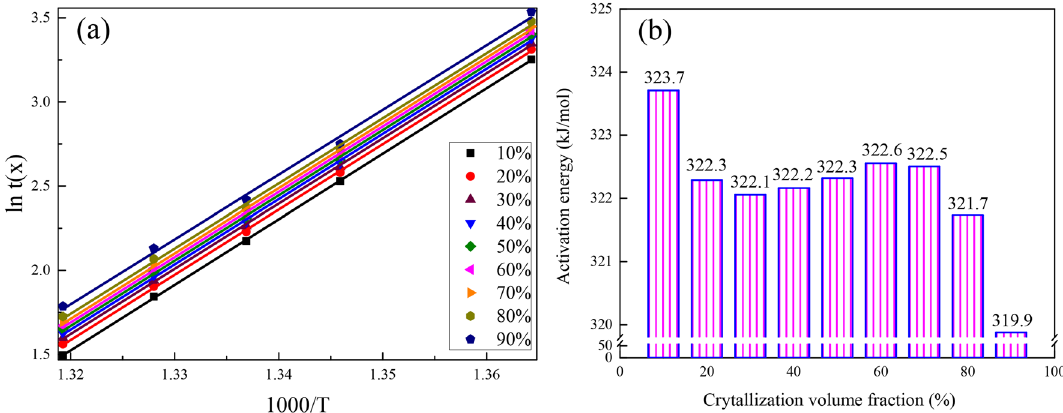
Figure 5. ( a ) Plots of ln t ( x ) versus 1000 /T and ( b ) activation energy E a versus crystallization volume calculated by Arrhenius equation 12,33 : t ( x ) = t 0 exp ( E a /RT ). Where t ( x ) is the time corresponding to crystallization volume fraction x , t 0 is a constant, E a is the crystallization activation energy, R is the molar gas constant, and T is the corresponding isothermal crystallization temperature. Figure 5a is obtained by plotting ln t ( x ) versus 1000/T and linear fitting the data under each crystallization volume fraction. The slope obtained by linear fitting can be calculated by the Arrhenius equation to acquire the relationship curve between the crystallization activation energy and the crystallization volume fraction x 8 , as shown in Fig. 5b. The crystallization activation energy of bulk amorphous alloy shows a decreasing trend as x increases. In the initial stage of crystallization, the higher activation energy of crystallization indicates that the alloy needs to break through a higher energy barrier for crystallization 20 . The crystallization activation energy decreases rapidly when 10% < x < 20%, implying that the crystallization behavior becomes easier after the initiation of crystallization. When 20% < x < 70%, the crystallization activation energy is basically stable at 322.3 kJ/mol, indicating that the crystallization reaction is comparatively stable in this process. When x > 70%, the crystallization activation energy reduces rapidly, indicating that the new crystal nucleation rate reduces rapidly in the ultimate stage of crystallization, the crystallization behavior transforms into crystals growth, and the residual amorphous matrix volume content inside alloy gradually decreases 12 . Therefore, it is difficult for atoms in amorphous alloys to advance nucleation, and the structure of amorphous alloy becomes comparatively stable after crystallization behavior 34 . This is basically consistent with the analysis result of Fig. 4. The average crystallization activation energy of this bulk amorphous alloy is 322.1 kJ/mol, which is higher than the other components’ in the same system of Zr–Cu–Ni–Al 12 . Thus, Zr 55.7 Cu 22.4 Ni 7.2 Al 14.7 bulk amorphous alloy has rela- tively great thermal stability.